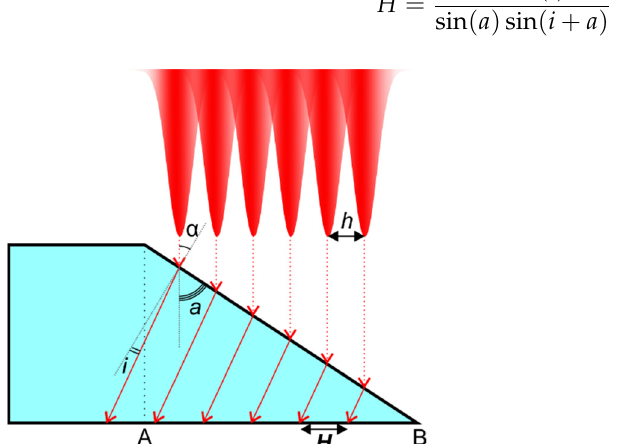
Figure 10. Schematic of the side view of the glass plate indicating a cumulative laser intensity profile falling on the channel (cut) sidewall, laser beam refraction, and impingement onto the back surface. Here, every scan consisted of multiple cut lines separated by the hatch distance h . Every cut line was scanned once per single scan.